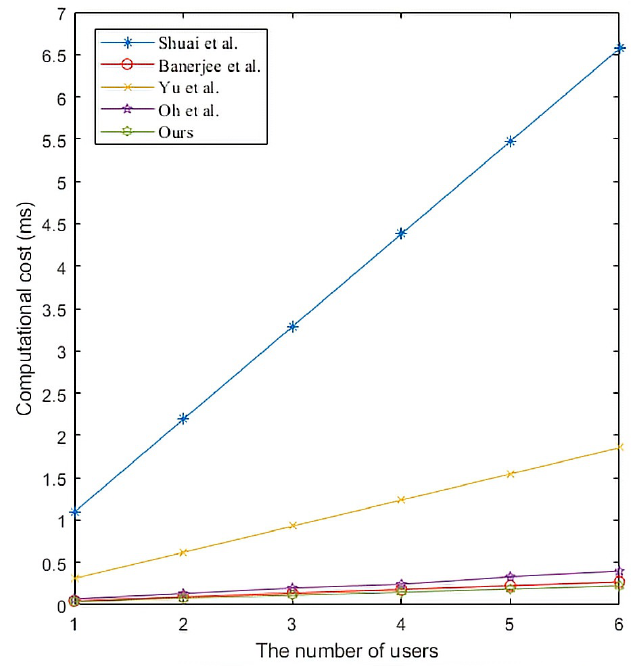
Figure 7. The computational cost of users. Shuai et al. [37], Banerjee et al. [40], Yu et al. [18], and Oh et al. [42].